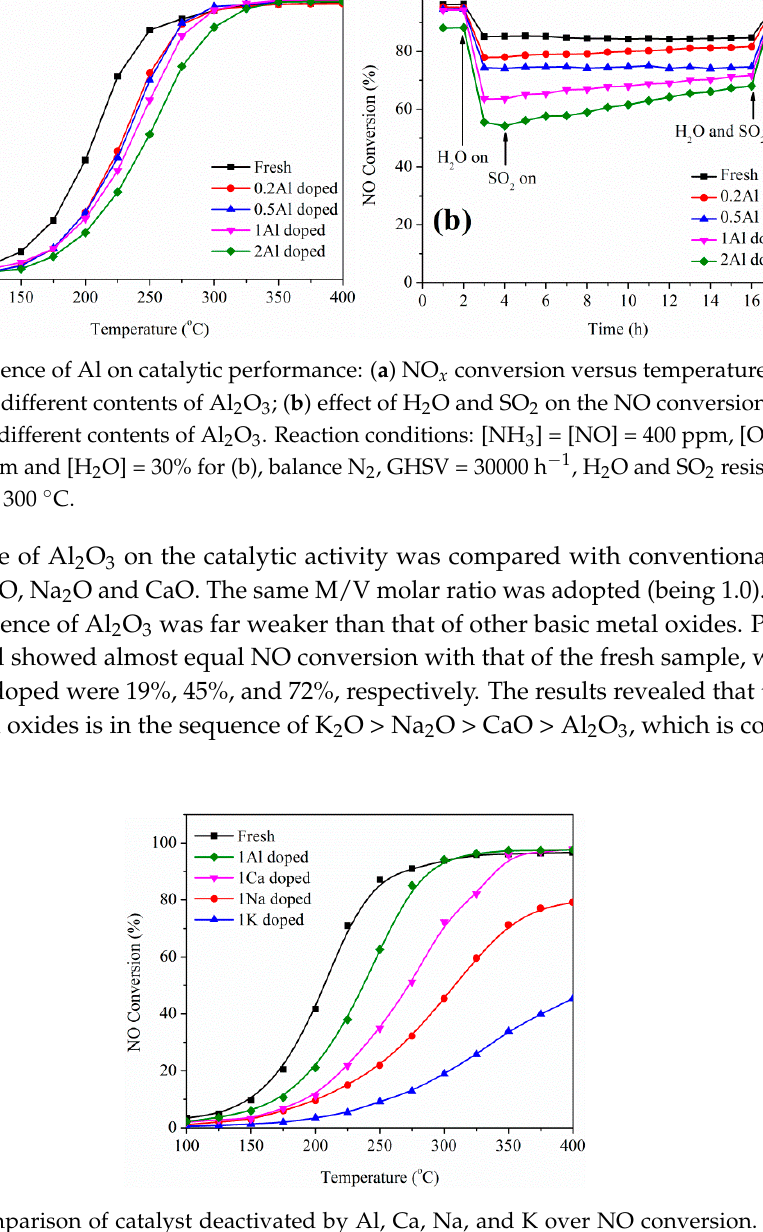
Figure 4. Comparison of catalyst deactivated by Al, Ca, Na, and K over NO conversion. Reaction conditions: [NH 3 ] = [NO] = 400 ppm, [O 2 ] = 0.5%, balance N 2 , GHSV = 30,000 h − 1 .